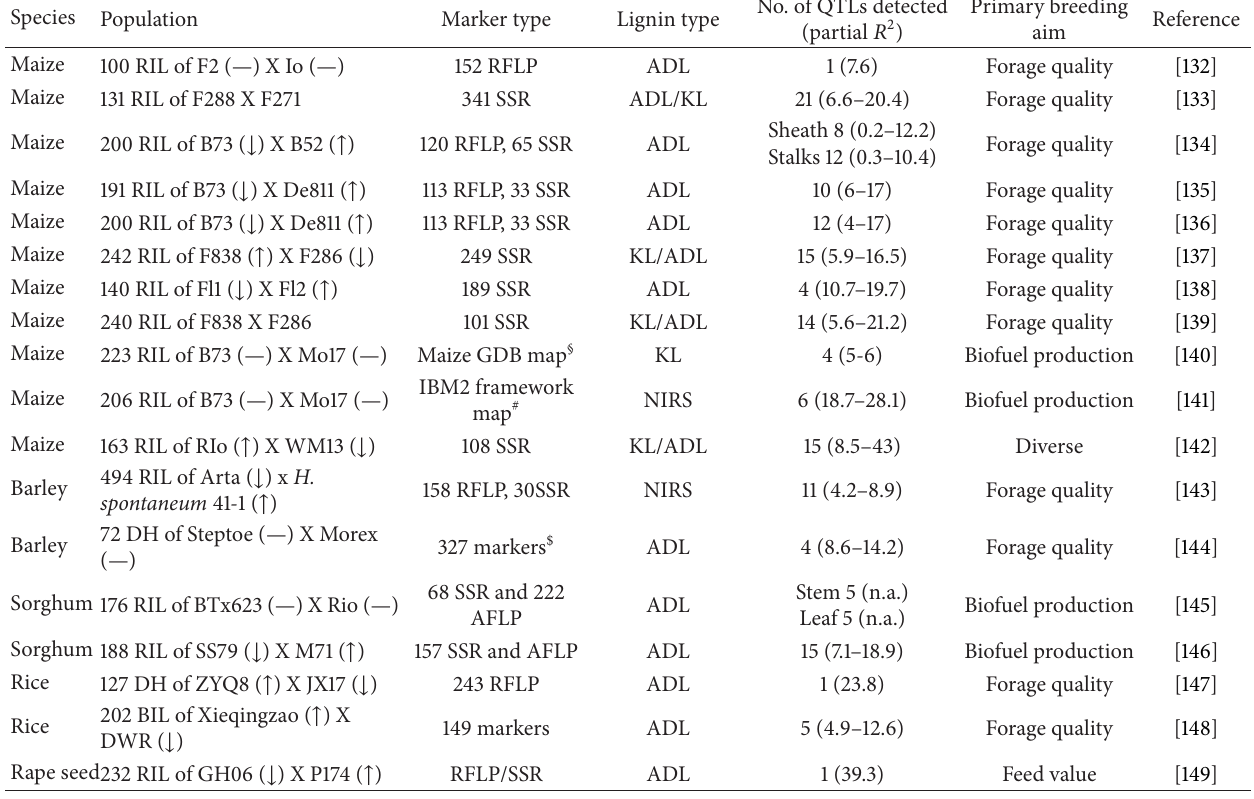
Table 3: Summary of studies reporting QTL for lignin content of different crop